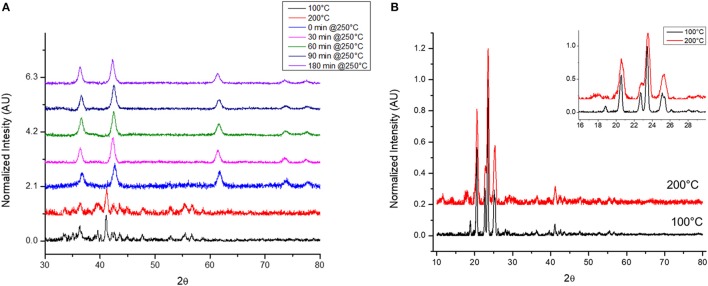
(A) Time-resolved synthesis at 0.06M CoAc, 250°C for f-CoO nanoparticles and (B) low-angle reflections.